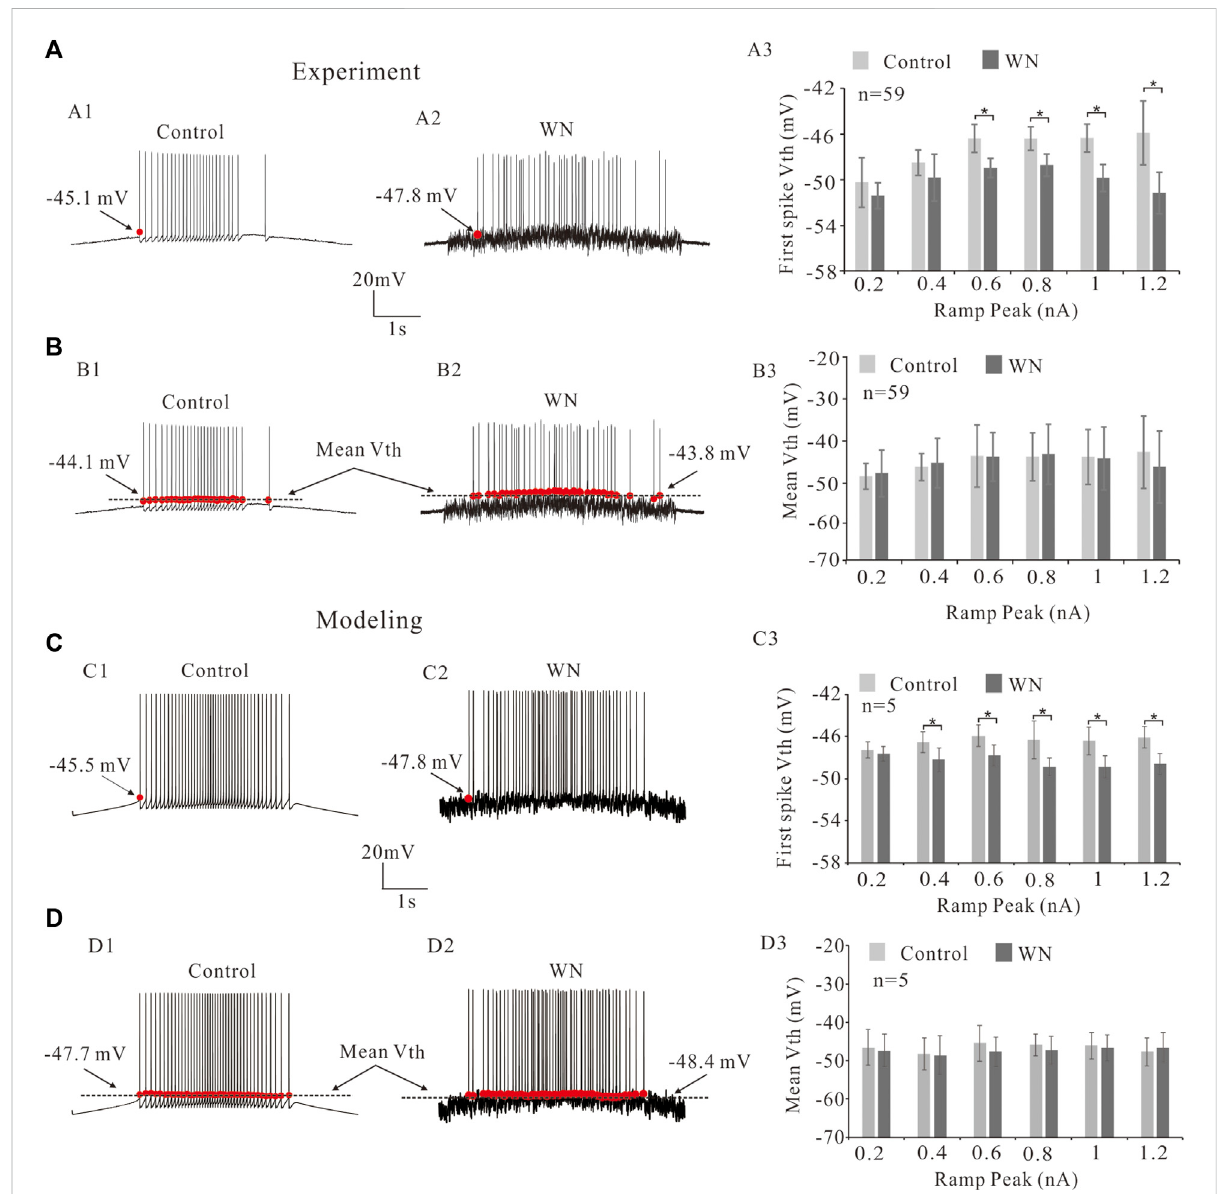
FIGURE 2 Effect of white noise on voltage threshold (V th ). (A) Repetitive fi rings were induced by current ramps in control (A1) and white noise (A2) . White noise hyperpolarized the V th for the fi rst spike (red dots in A1,A2 ). Statistical results showed that the white noise signi fi cantly reduced V th for the fi rst spikes from ramp peaks of 0.6 – 1.2 nA ( p < 0.05, A3). (B) The effects of white noise on the mean values of V th for all spikes (black lines in B1,B2 ). Statisticalresultsshowedthatwhitenoisedidnotsigni fi cantlyreducethemeanvaluesofV th (B3) . (C) :Modelingresultsshowedthatwhitenoise signi fi cantly reducedthe fi rstspikeV th (reddotsin C1,C2 )fromramppeaksof0.4 – 1.2 nA( p < 0.05). (D) :Statisticalresults (D3) showedthattherewas no signi fi cant change in the mean values of V th for all spikes (black lines in D1,D2 ). Data are expressed as mean ± SD. Paired t -test was performed. * p <